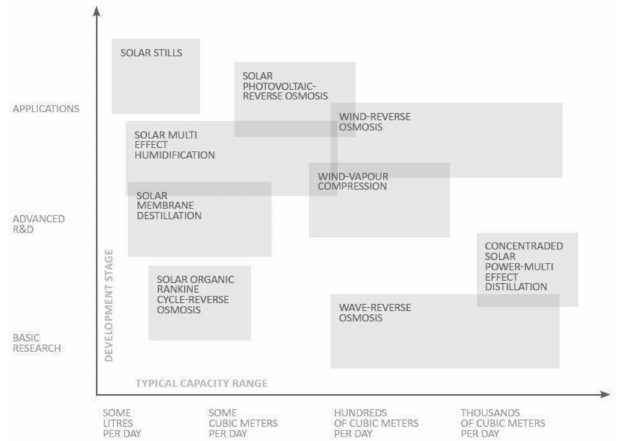
Figure 6. Renewable desalination technologies [23].